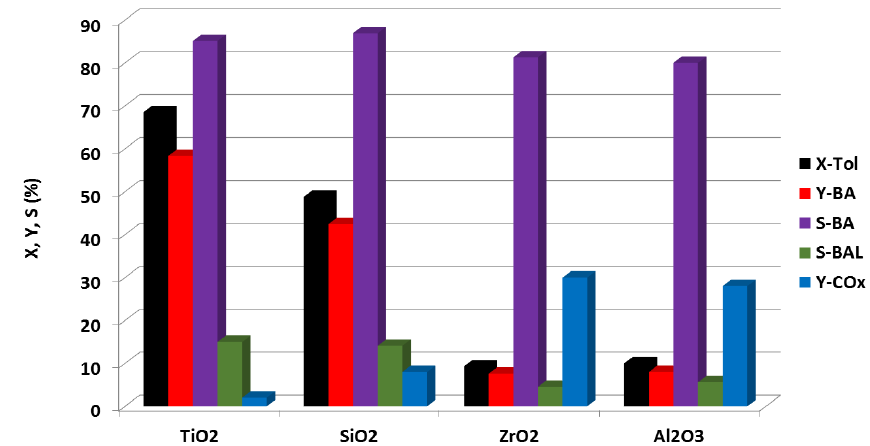
Figure 8. Effect of kind of carrier on the catalytic performance of 10% Pd ‐ 8% Sb/support catalyst (Reaction conditions: Tol:AcOH:O 2 (air):Ar = 1:4:3(15):4; GHSV = 2688 h − 1 ; τ = 1.34 s; T = 210 °C; P = 2 bar).